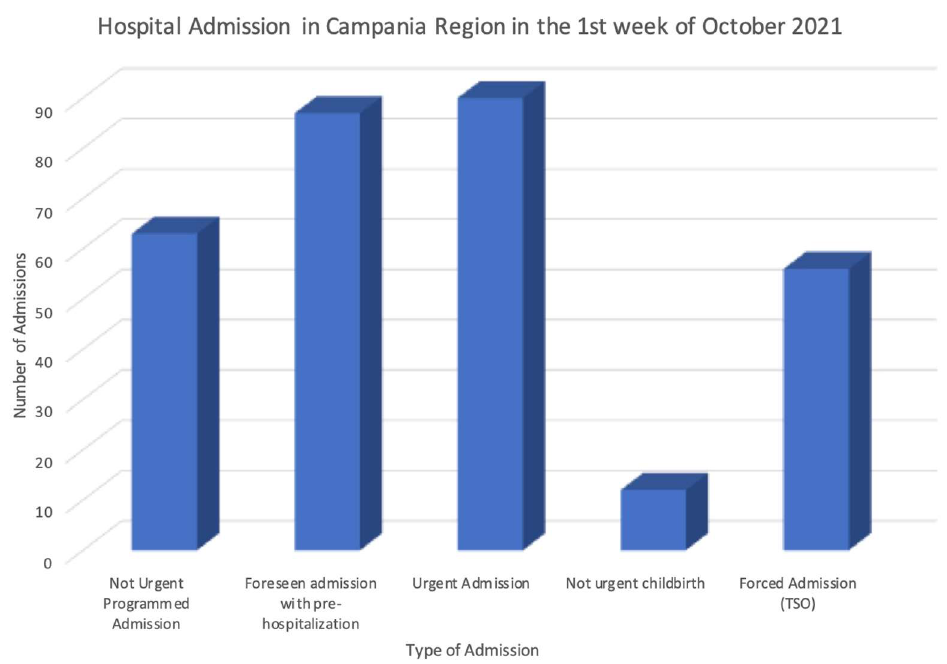
Figure 4. Example of statistics obtained through the secondary use of the data .